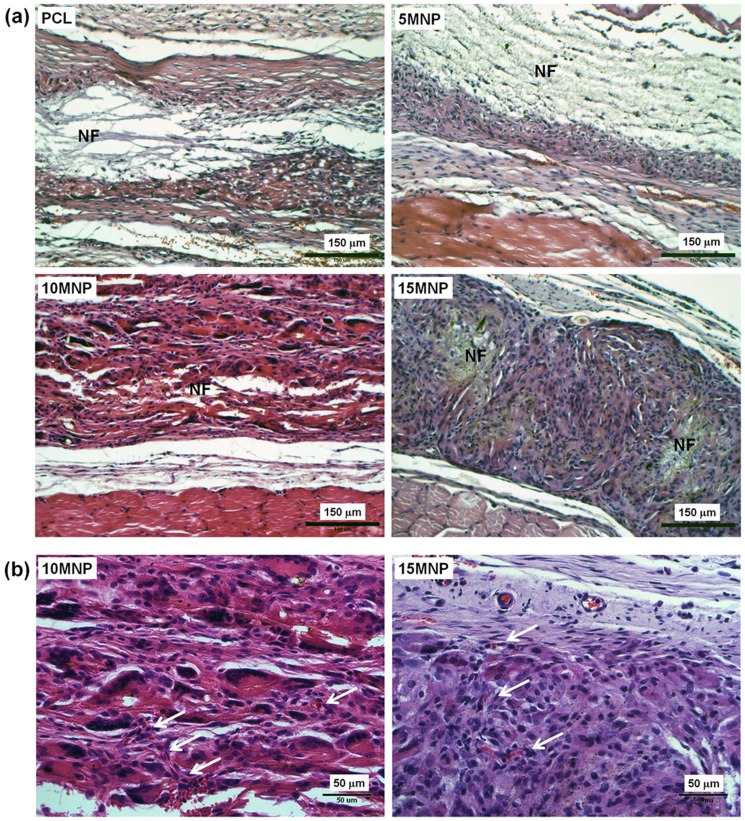
Histological views of the nanofiber scaffolds (PCL, 5MNP, 10MNP and 15MNP) after implantation in rat subcutaneous tissue for 4 weeks.Images at (a) low and (b) high magnification. Tissue samples were H&E stained and visualized under optical microscopy. Connective tissue was formed in areas between the scaffold and adjacent tissues. Neovascularization was also found within the scaffolds (indicated as arrows in (b)). Considerable degradation of scaffolds was noticed particularly in 10MNP and 15MNP, which was not readily observed in pure PCL and 5MNP (‘NF’ in (a) indicates the remaining part of nanofiber scaffold without being degraded). Fibroblasts actively migrated to the site of degradation, and activated fibroblasts were easily detected within the remaining scaffold area.